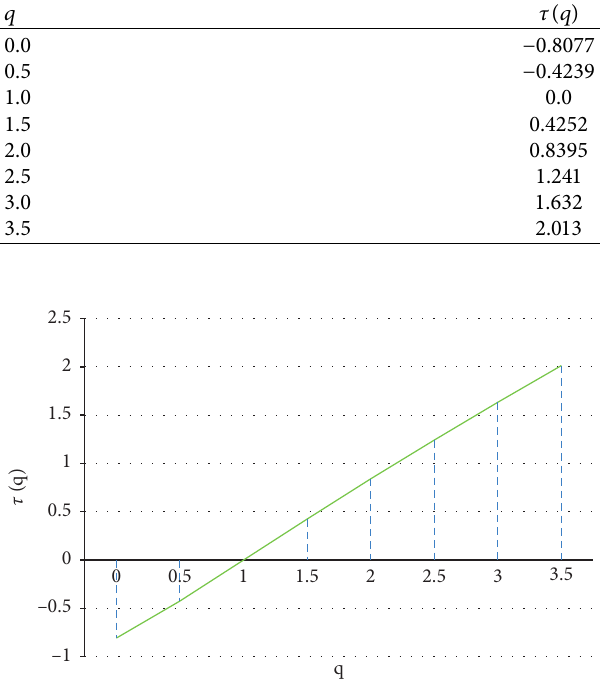
Figure 2: Relationship between network rumors τ ( q ) − q .